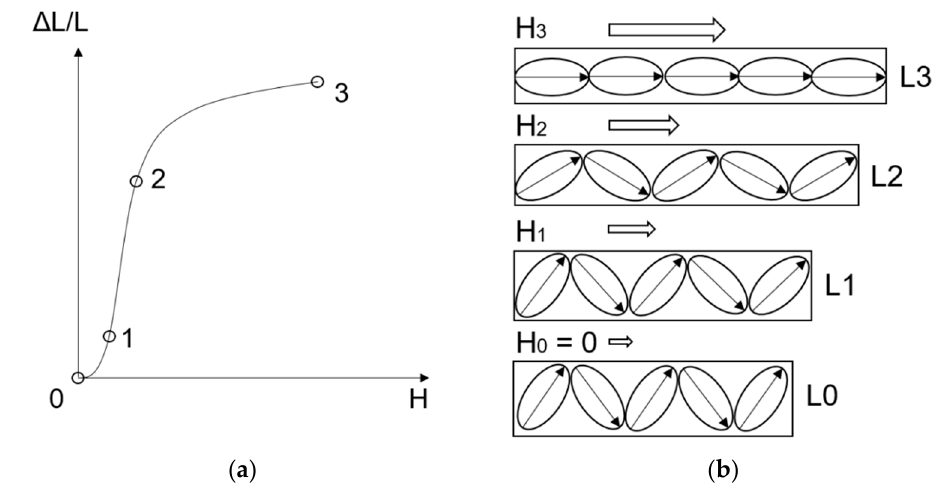
Figure 2. Magnetostrictive effect explained on ( a ) magnetic field strain diagram with additional ( b ) schematic step subscription [8].